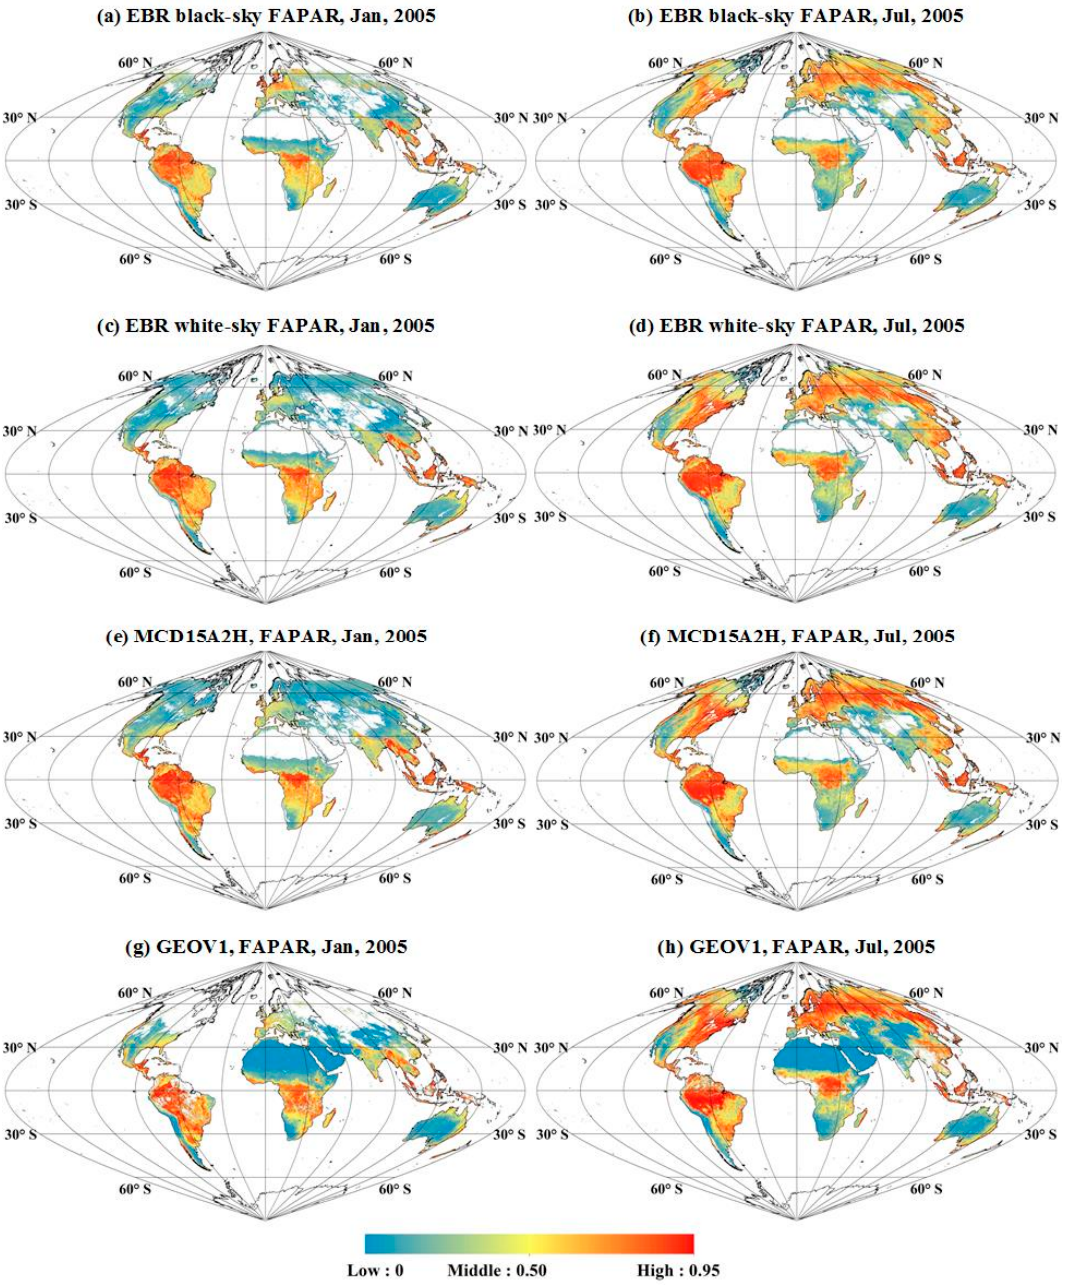
Figure 11. Spatial variation of the monthly mean FAPARs for January (left) and July (right) in 2005: ( a – b ) EBR method-based black-sky FAPARs; ( c – d ) EBR method-based white-sky FAPARs; ( e – f ) MCD15A2H FAPARs; and ( g – h ) GEOV1